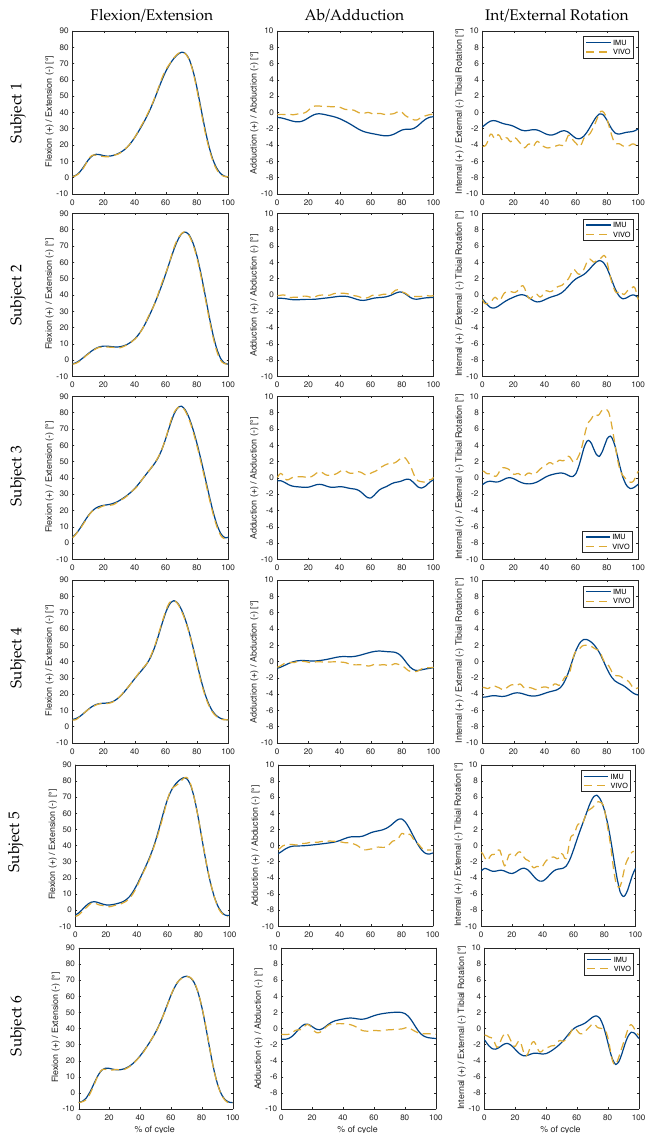
Figure 4. Stair Descent: Knee joint angles were plotted over the progression (expressed as a percent- age) of one complete gait cycle. The solid blue line illustrates the angles estimated using inertial data. The dashed gold line illustrates the ground truth angles performed by the joint simulator. Each row represents one subject, while each column presents rotations in a different plane relative to the femoral coordinate